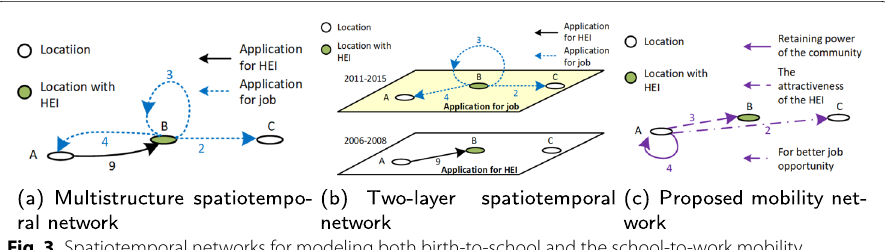
Fig. 3 Spatiotemporal networks for modeling both birth‑to‑school and the school‑to‑work